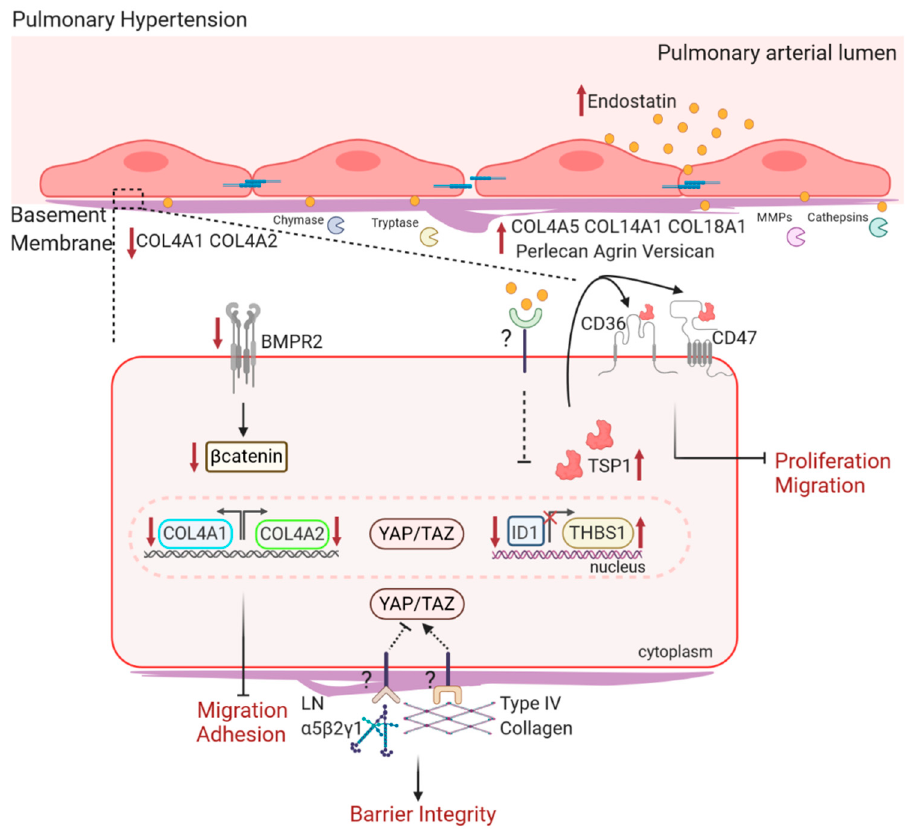
Figure 2. Current knowledge on the role of basement membrane components in pulmonary endothelial cell function in IPAH. In IPAH, the structure and composition of the BM is altered [4]. In PAs, COL4A5, COL14A1, COL18A1, perlecan, agrin, and versican levels are increased [5,174,175]. In the circulation, increased levels of endostatin, matrikine of type XVIII collagen α 1, are found, which correlates with disease severity and survival [5,41]. In ECs of PAH patients, COL4A1 and COL4A2 are reduced [173]. COL4A1 and COL4A2 are downstream targets of BMPR2, as reduced levels of BMPR2 and β -catenin lead to decreased COL4A1 and COL4A2 expression, resulting in impaired migration and adhesion [173,176]. The culture of PAEC on type IV collagen and laminin strengthen barrier and integrity. While adhesion to type IV collagen triggers nuclear translocation of YAP / TAZ, adhesion to laminin α 5 β 2 γ 1 retains YAP / TAZ in the cytoplasm [4]. Endostatin blocks ID-1 gene expression and decreases THBS1-transcription and production [177]. In return, TSP-1 inhibits pulmonary EC proliferation and migration via CD36/CD47, suggesting an endostatin–ID1–TSP1 axis